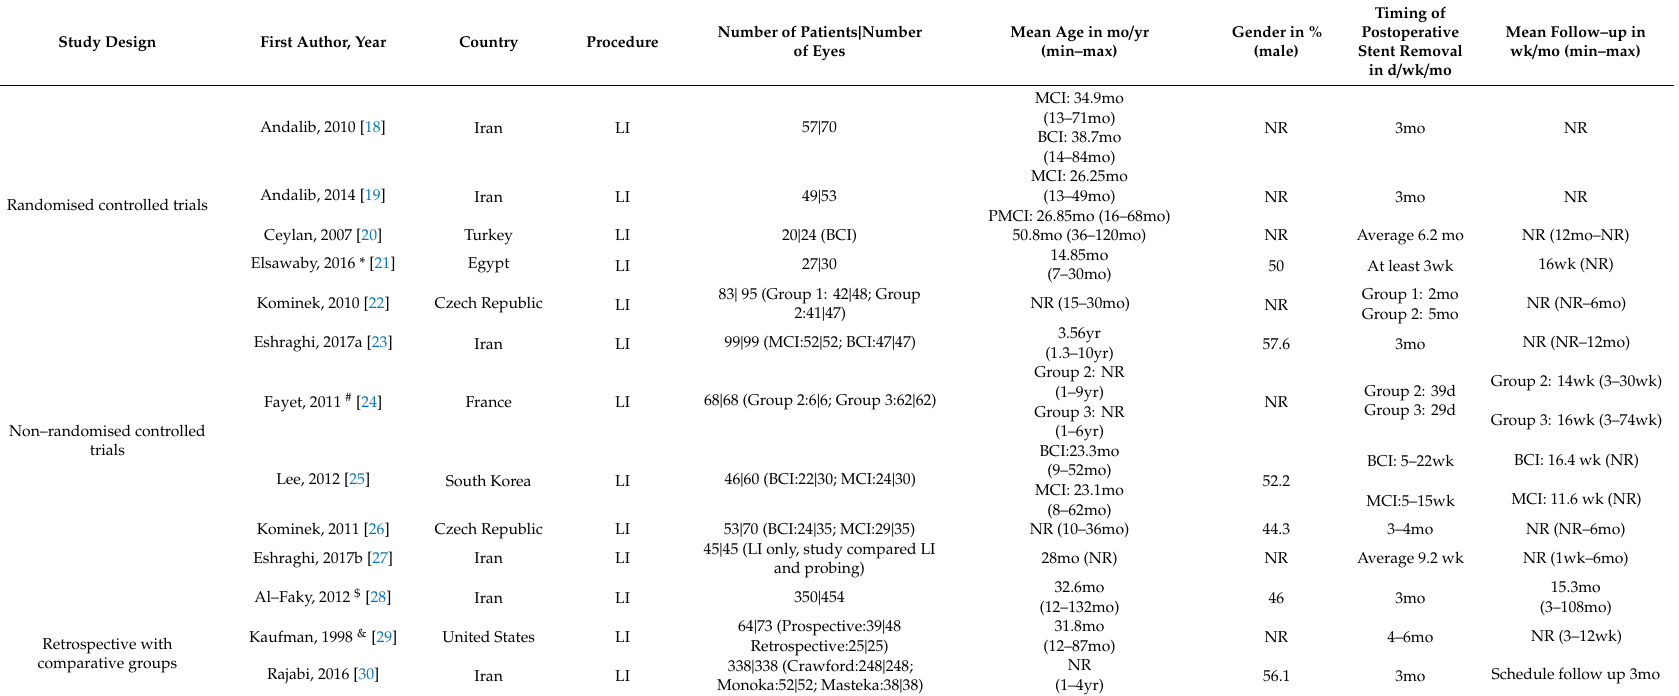
Table 1. Characteristics of the studies